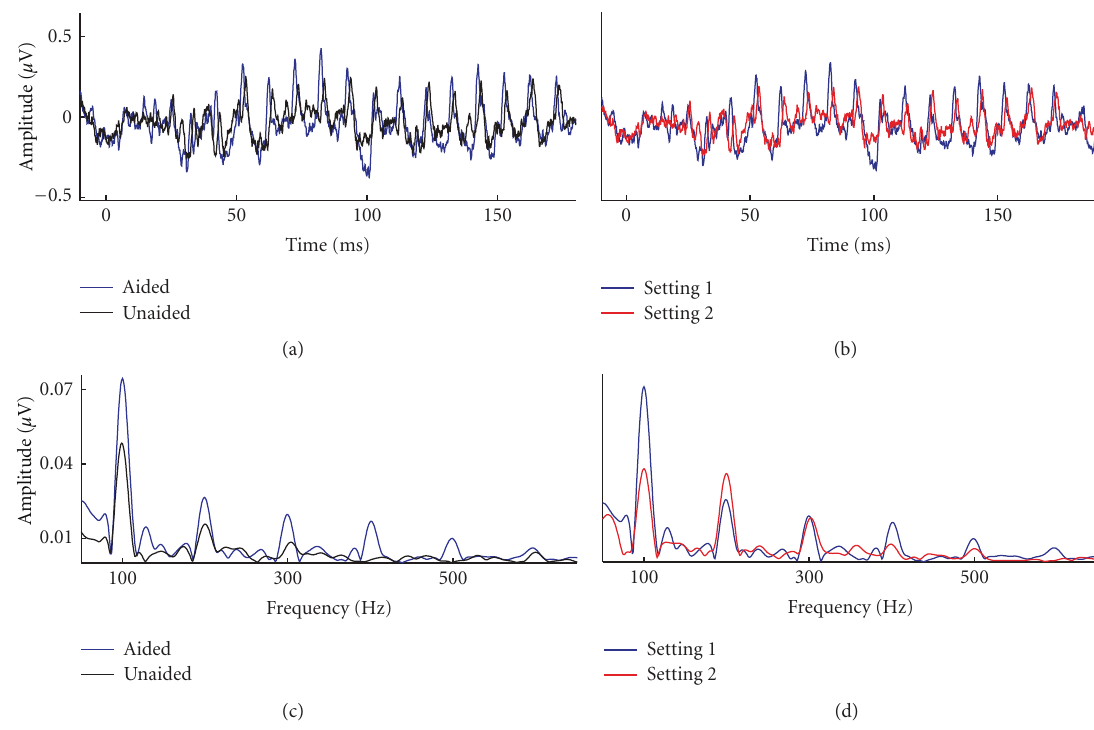
Figure6:Responseswereobtainedtothestimulus/da/presentedat80 dBSPLinsoundfieldinaided(blue)versusunaided(black)conditions ((a) and (c)) and different settings in the same hearing aid ((b) and (d)). Responses show greater RMS and 𝐹 0 amplitudes in aided versus unaided conditions and for setting 1 versus setting